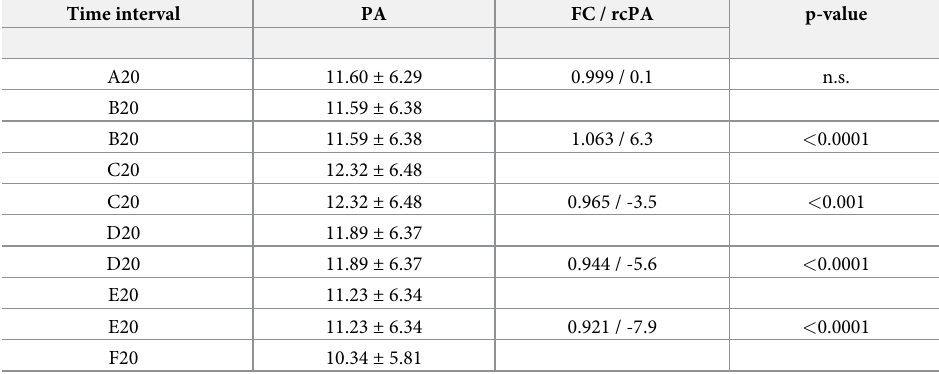
Table 3. Comparison of physical activity of adjacent time intervals within 2020.